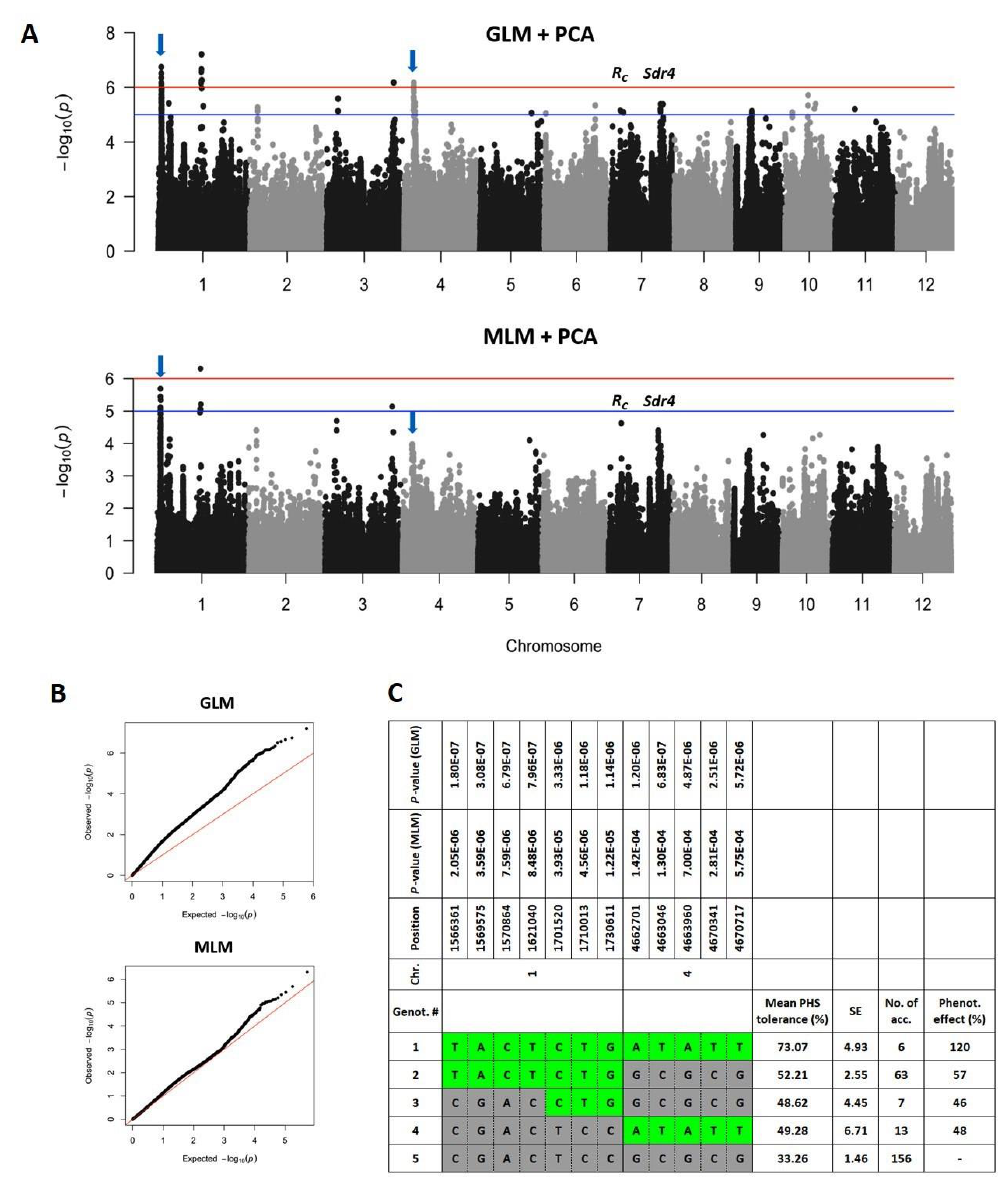
Figure 5. Genome-wide association analysis of pre-harvest sprouting (PHS) of Japonica rice accessions: ( A ) Manhattan plot generated through the general linear model (GLM) with principal components and mixed linear model (MLM) with kinship matrix and principal components. Points above the blue and red threshold lines indicate significant association at − log10( p ) = 5 and 6, respectively. Arrows indicate two major loci used for haplotype analysis in Figure 5C. R C and Sdr4 loci are major dormancy genes in rice; ( B ) quantile–quantile plots; and ( C ) haplotype effects on the phenotype trait.